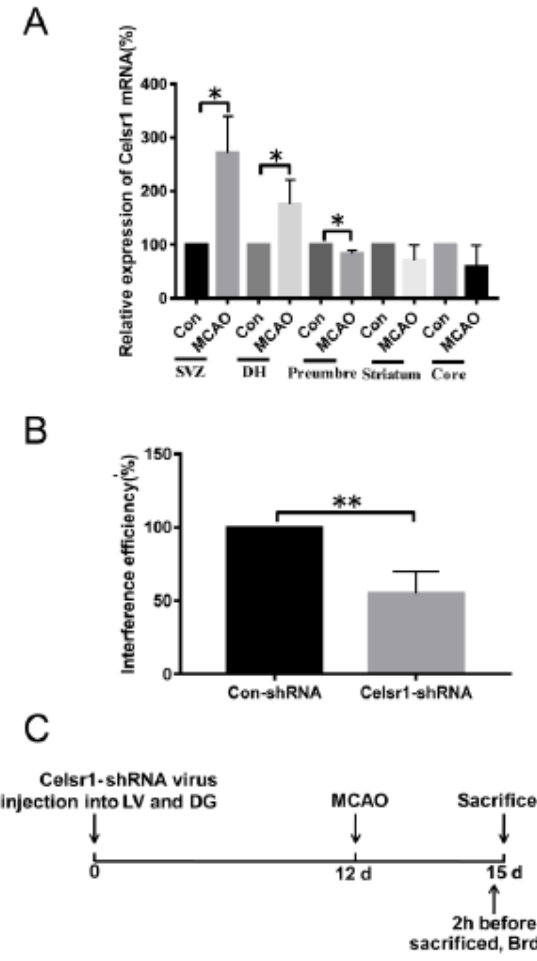
Figure 1. The expression of Celsr1 in the different brain areas of middle cerebral artery occlusion (MCAO) rats. ( A ) After 2 h of ischemia/24 h of reperfusion, q-PCR was conducted in the subventricular zone (SVZ), dentate gyrus (DG), ischemic penumbra, ischemic core and ischemic cortex ( n = 3 in each group). * p < 0.05. ( B ) The interference efficiency of the Celsr1 -shRNA lentivirus in 293 cells was tested by q-PCR ( n = 3, the experiment was repeated 3 times). ** p < 0.01. ( C ) Experimental scheme of pretreatment with the Celsr1 -shRNA lentivirus.